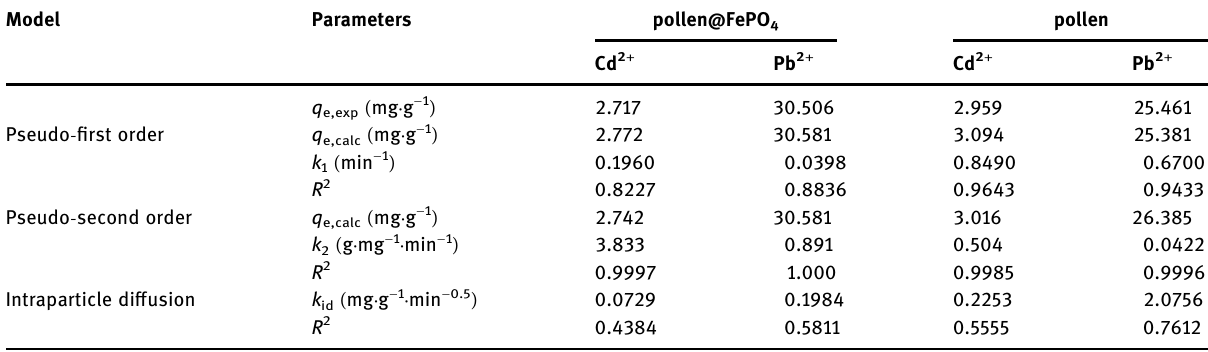
Table 1: Kinetic parameters for the adsorption of Cd 2 + /Pb 2 + on pollen@FePO 4 /pollen